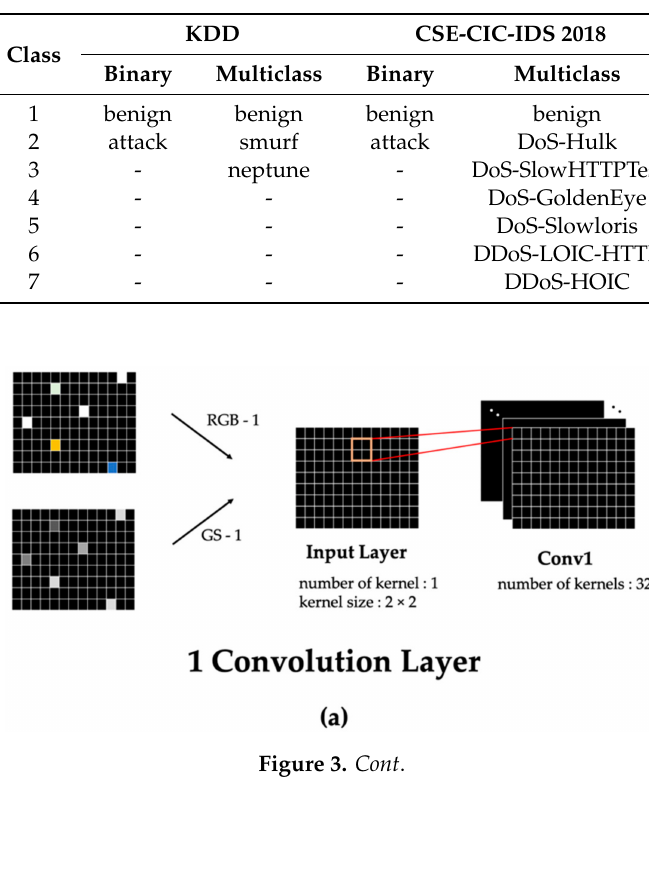
Table 4. Classes for Binary and Multiclass classifications.